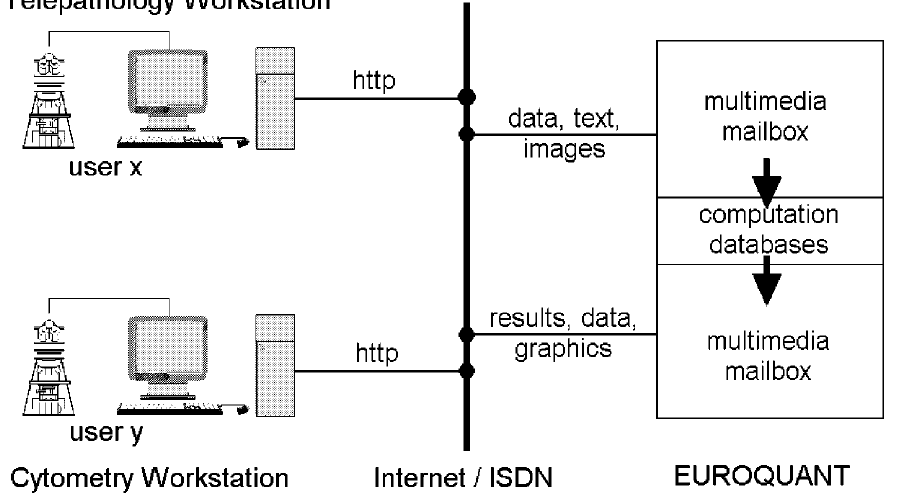
Fig. 1. Data flow from workstations via Internet or ISDN to the quantitation server and vice